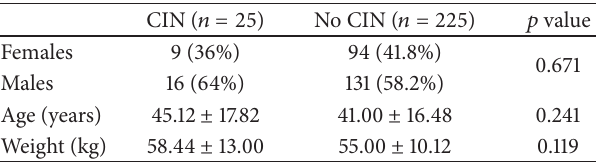
Table 1: Demographic distribution between “CIN group” and “No CIN